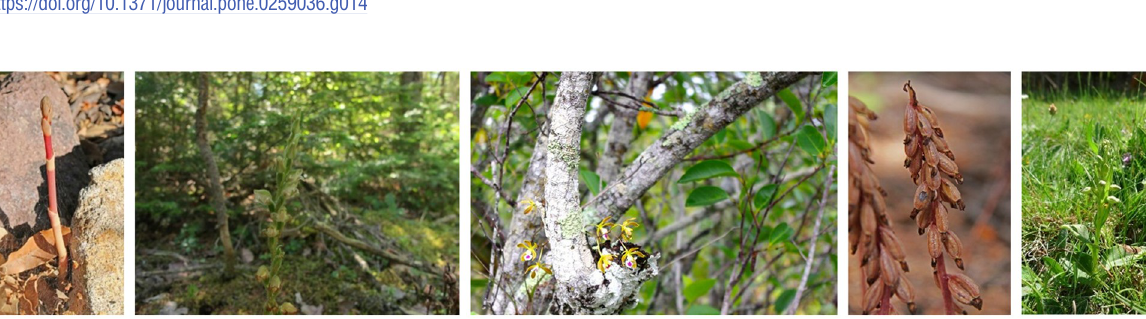
Fig 15. Examples of images that are hard to classify because of photographic imperfections or non-blooming stages of the orchid.